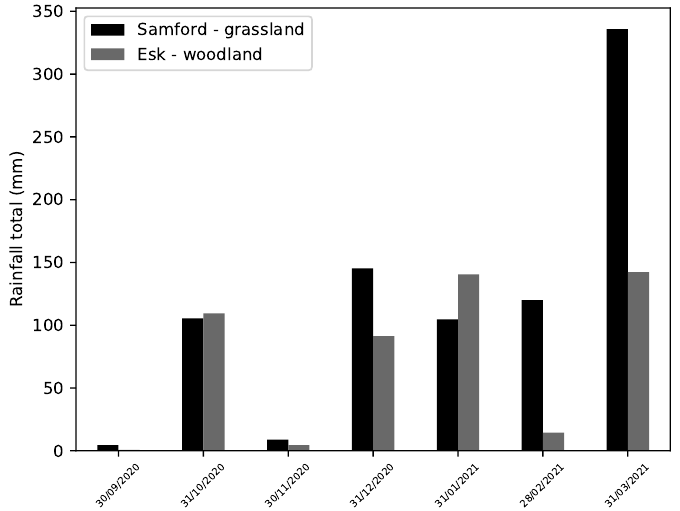
Figure2. MonthlyrainfalltotalsforbothfieldsitesfromSeptember2020toMarch2021. Figure 2. Monthly rainfall totals for both field sites from September 2020 to March Table1. Fieldsitecharacteristics.